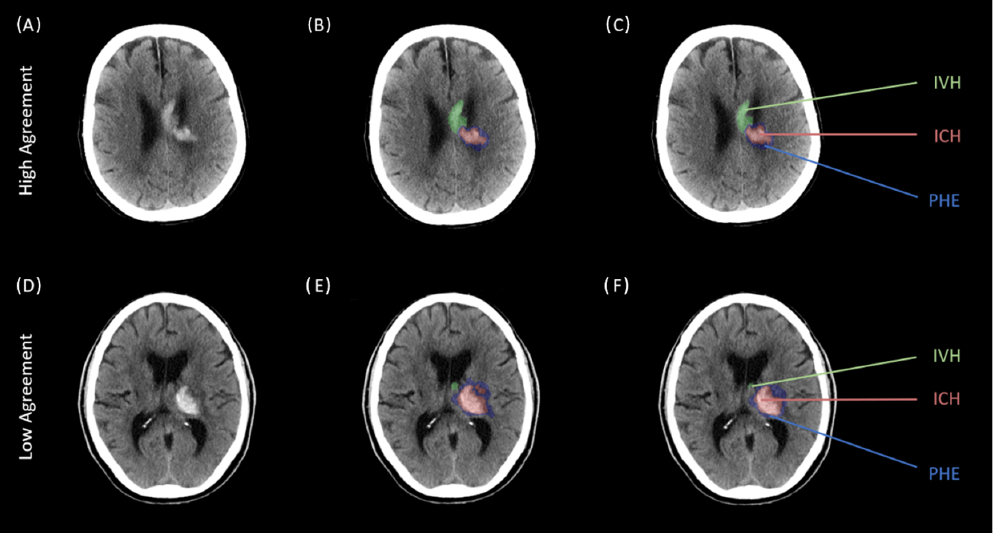
Figure 2. Two representative cases of high and low intrarater agreement comparing two different segmentations of one rater across two separate readings. Legend: Two representative cases of intrarater agreement for the segmentation of intracerebral hemorrhage (ICH; red), perihematomal edema (PHE; blue), and intraventricular hemorrhage (IVH; green) across two separate readings of one rater. ( A – C ): Above case representing high agreements with corresponding NCCT scan ( A ), first reading ( B ) and second reading ( C ). ( D – F ): Below case representing low agreements with corresponding NCCT scan ( D ), first reading ( E ) and second reading ( F ). ICH indicates intracerebral hemorrhage; IVH, intraventricular hemorrhage, PHE, perihematomal edema.